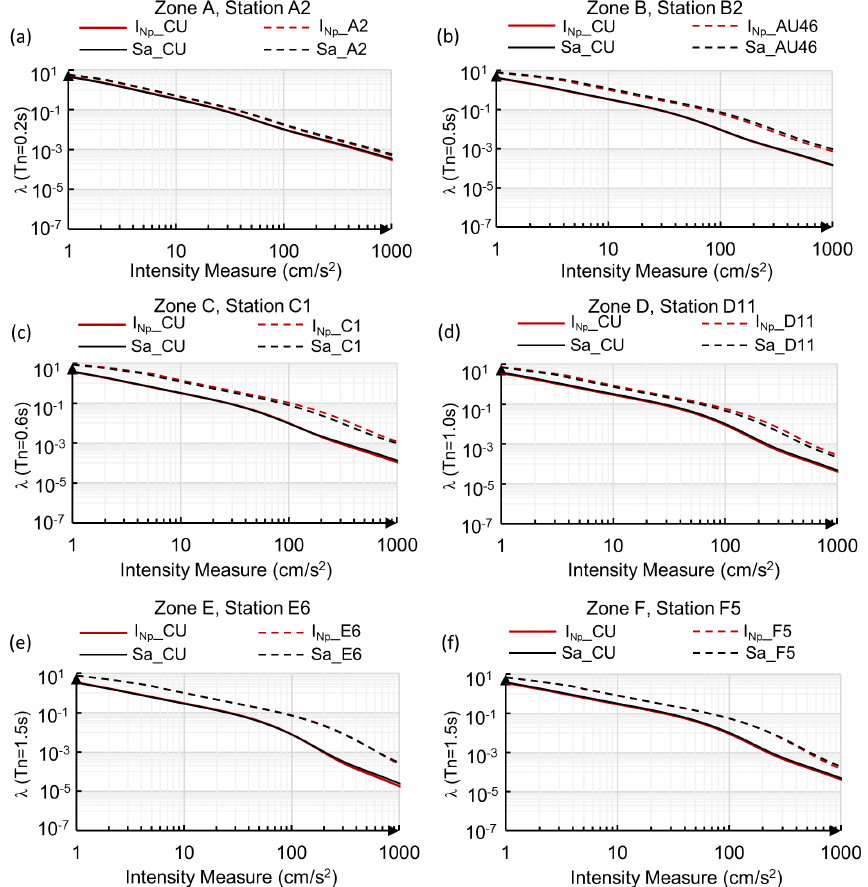
Figure 6. Mean annual rate of exceedance ( λ ) of Sa( T 1 ) and I N of each zone listed in Table